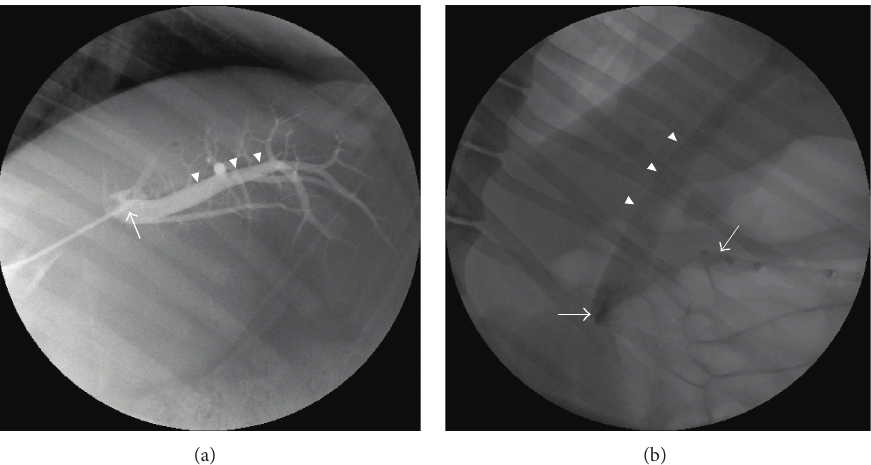
Figure 4: Angiographic demonstration of venous sampling sites. (a) Digital fluoroscopic image demonstrating the catheter tip (white arrow) in position for obtaining samples from the distal left portal vein (white arrowheads). (b) Digital fluoroscopic image demonstrating the splenoportal confluence (white thick arrow). Note the opacified splenic vein (white thin arrow) and the long extra-hepatic course of the portal vein (white arrowheads).